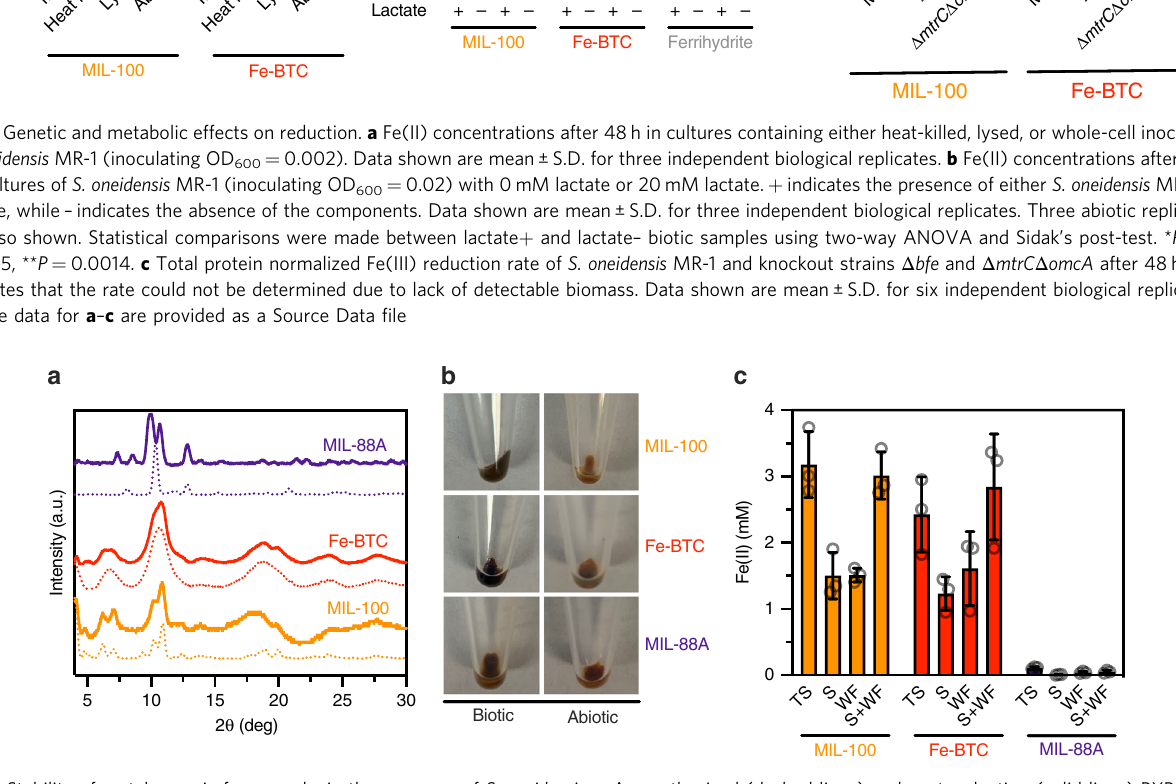
tively con fi rmed that Fe(II) was contained within each framework by measuring Fe(II) in pelleted/washed samples of biotic MIL-100 and Fe-BTC (Fig. 4c). Nonetheless, ca. 50% of the total reduced Fe in framework suspensions was soluble Fe(II) after 48 h of microbial culture. Similar to observations with iron oxides that are partially solubilized upon microbial reduction, our results indicate that S. oneidensis can both directly reduce Fe(III) in MIL- 100 and Fe-BTC and partially remove Fe(II/III) from the fra- mework structure while maintaining framework stability 25 .